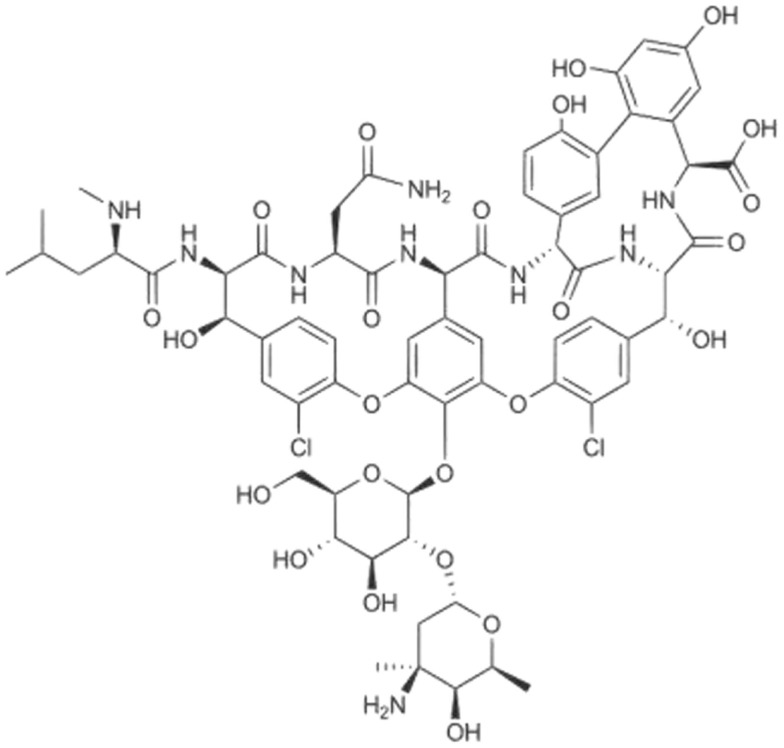
Vancomycin structure.